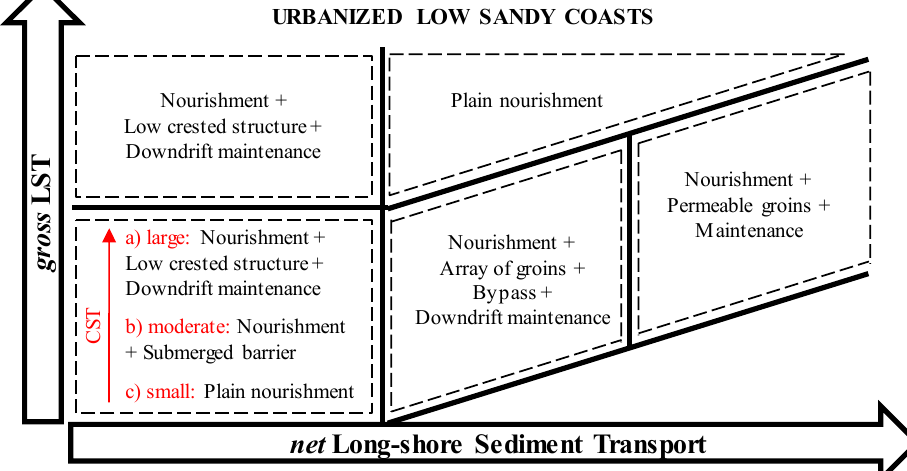
Figure 3. Guidelines for erosion mitigation strategies ( div(LST) = divergence of long-shore sediment transport, CST = cross-shore sediment transport) for urbanized low sandy coasts.